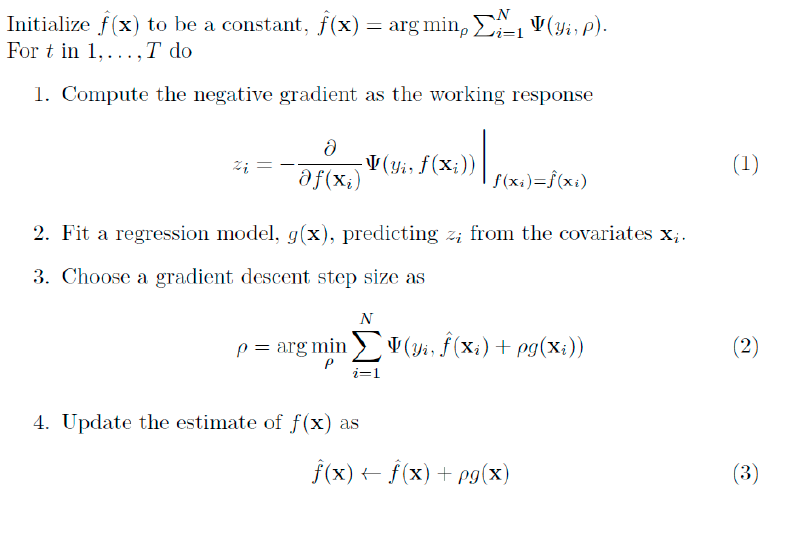
Figure 3. Algorithm of the gradient boosting model.